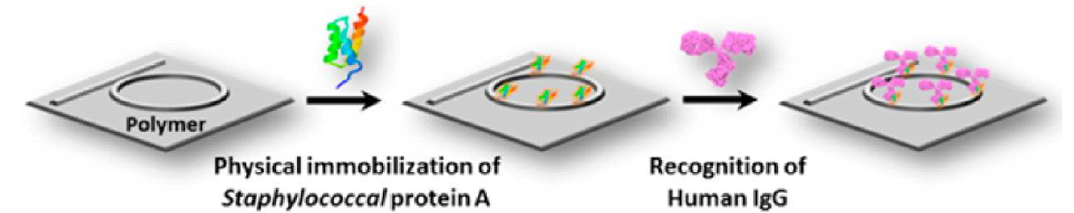
Figure 26. Schematic of the biosensing process using PA/IgG affinity couple [9].